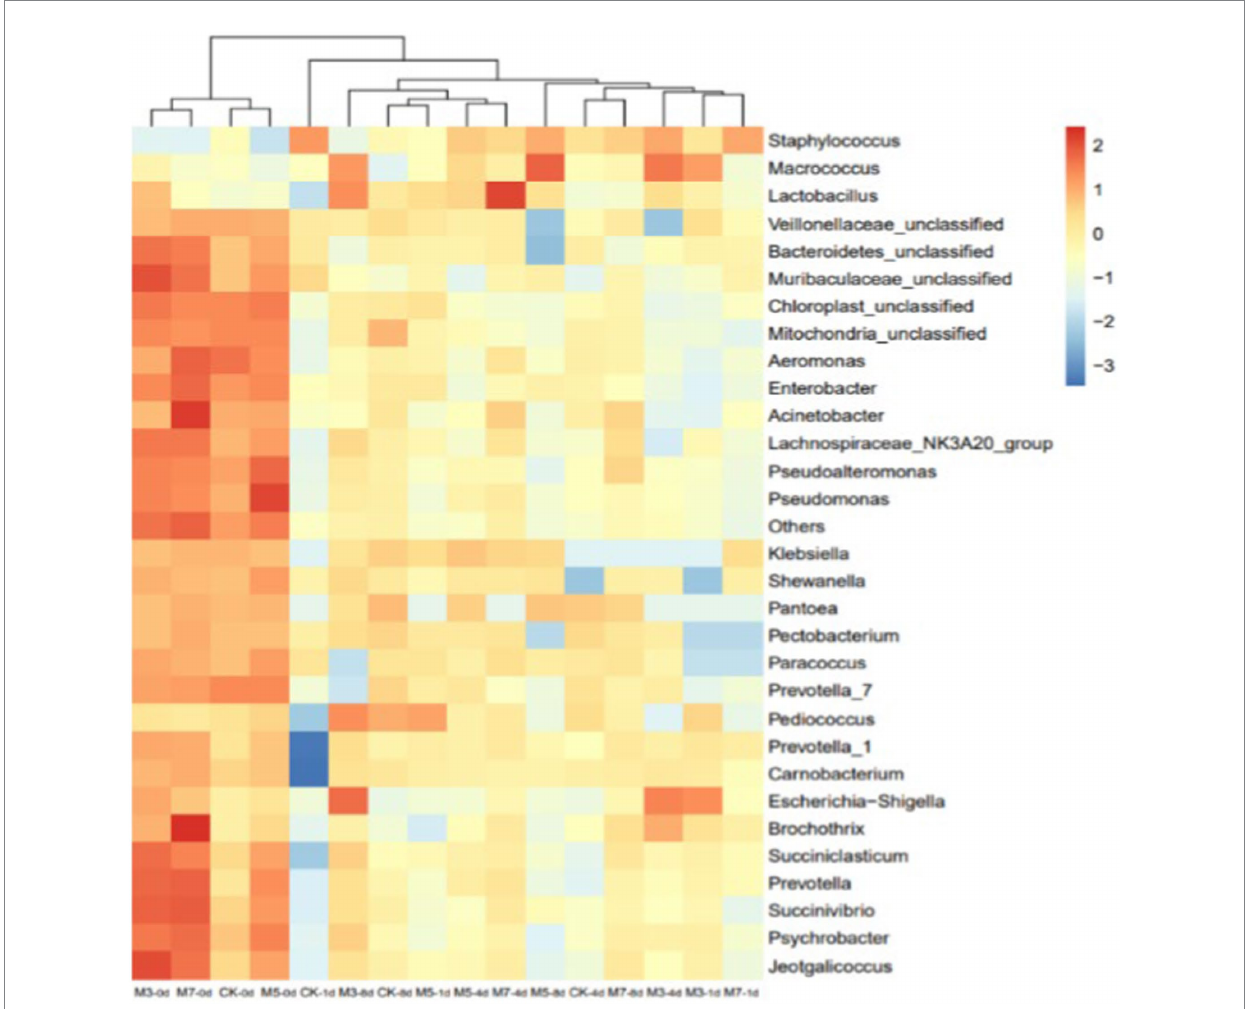
FIGURE 3 Bacterial community heatmap analysis and sample similarity tree at genus-level phylotype. In the heat map, red and blue represented high and low relative abundances,